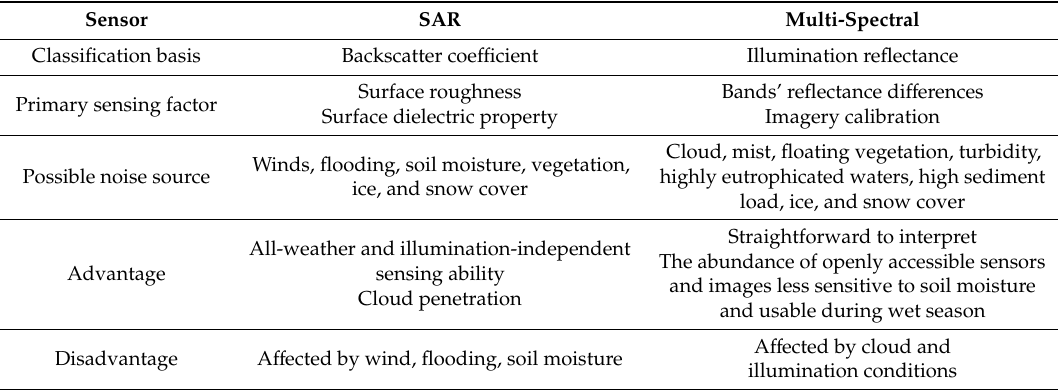
Table 2. The comparison of the advantages and disadvantages of using SAR and the multispectral sensor for waterbody